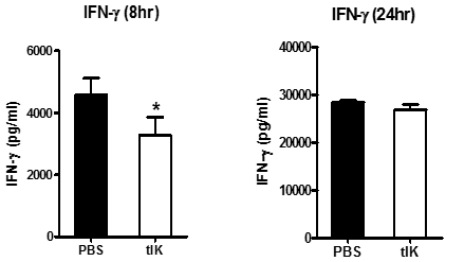
Figure 3. Treatment with tIK protein suppresses the production of pro-inflammatory cytokine, IFN- γ , during CD4 + T cell activation. CD4 + T cells isolated from 7-week-old Balb/c mice using magnetic activated cell sorting were activated with anti-CD3 and anti-CD28 antibodies (each 1 μ g/mL) for 8 h and 24 h. Phosphate-buffered saline (PBS) or tIK protein was added to the cells at the same time as treatment with anti-CD3 and anti-CD28 antibodies. The concentrations of IFN- γ in the supernatants were measured by ELISA. Data is represented as the mean ± SD ( n = 3), * p < 0.05.